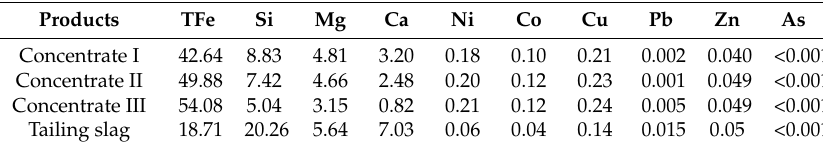
Table 3. Compositions of concentrates and tailing slag (wt